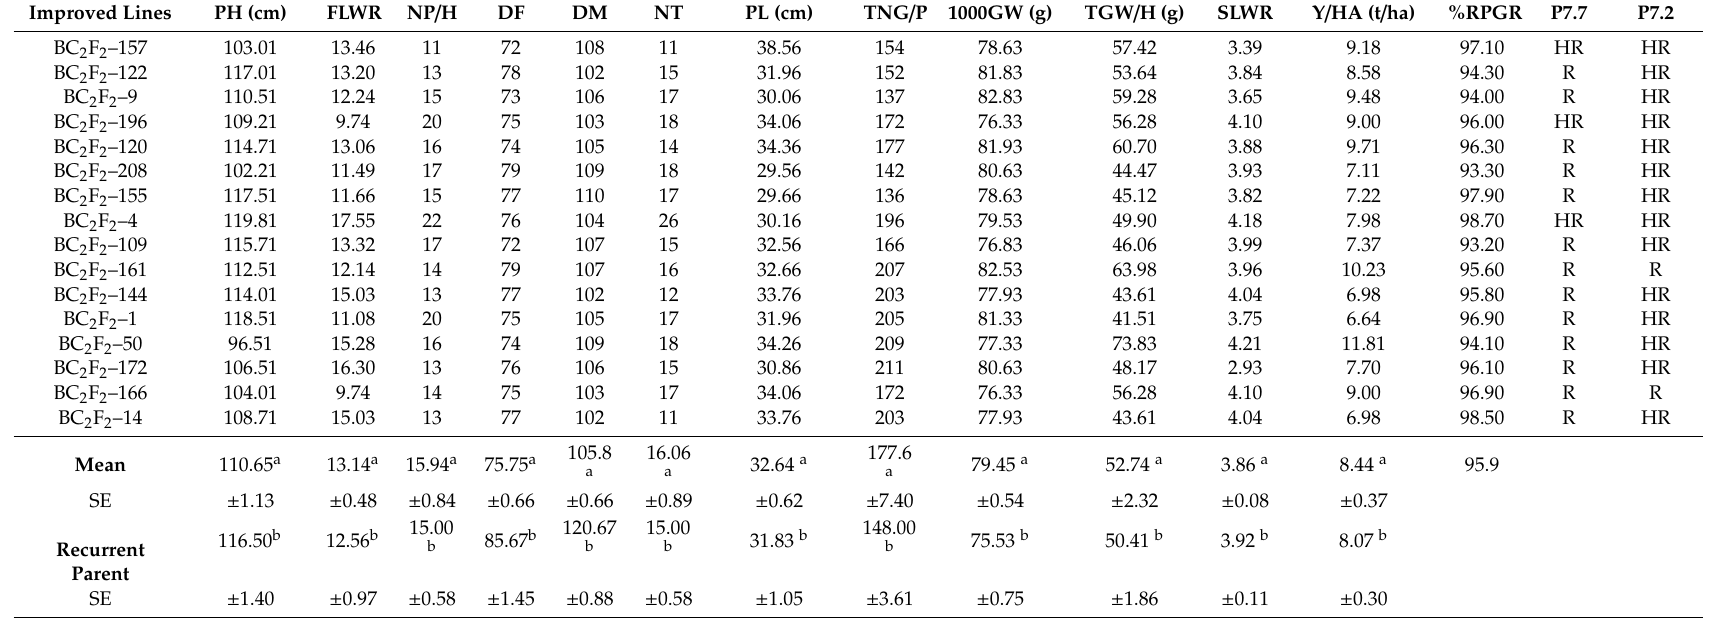
Table 4. Comparative agro-morphological performance of the selected improved